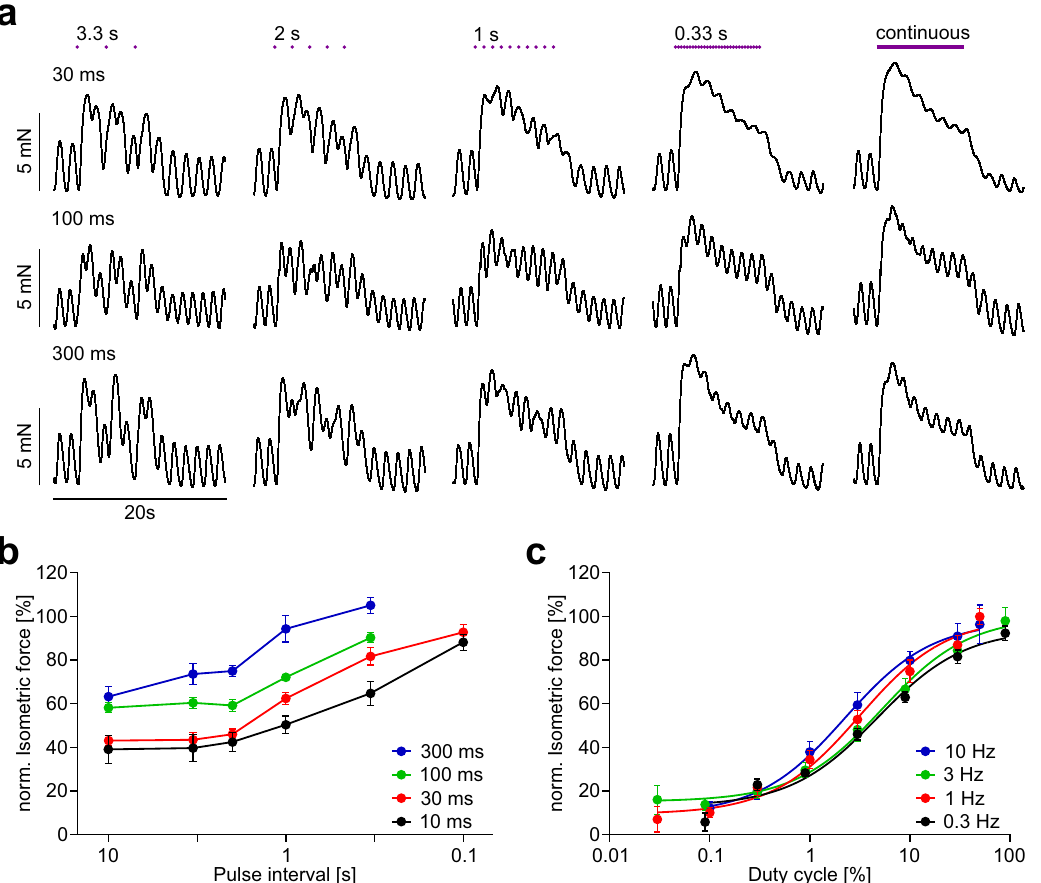
Fig. 9 Ef fi cacy of pulsed illumination in the small intestine. a Representative traces of isometric force using different illumination patterns (violet dots, 1 mW/mm 2 ) with decreasing pulse intervals (3.3 s, 2 s, 1 s, 0.33 s and continuous light) at different pulse lengths (30 ms, 100 ms, 300 ms). b Aggregated data of the dependence of the normalized maximal isometric force amplitude on the pulse interval at various pulse durations ( N = 2, n = 8). c Analysis of duty cycle to isometric force relationship when using 0.3 (black, N = 2, n = 8), 1 (red, N = 3, n = 12), 3 (green, N = 3, n = 12), and 10 Hz (blue, N = 3, n = 12) repetition rates with changing pulse durations (1 mW/mm², 10 s long illumination pattern). Peak isometric force was normalized to the ones from continuous illumination, shown is the mean and the respective Hill fi t. Data are presented as mean values